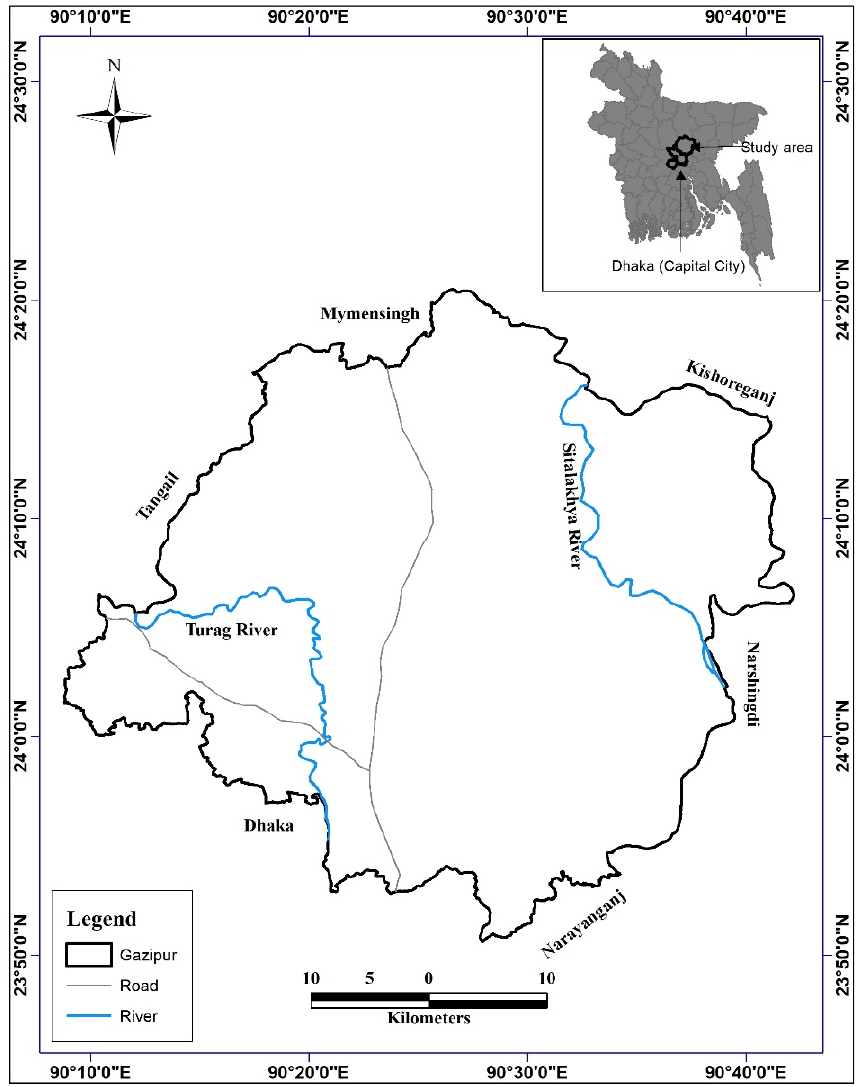
Figure 1. Location map of the study area.